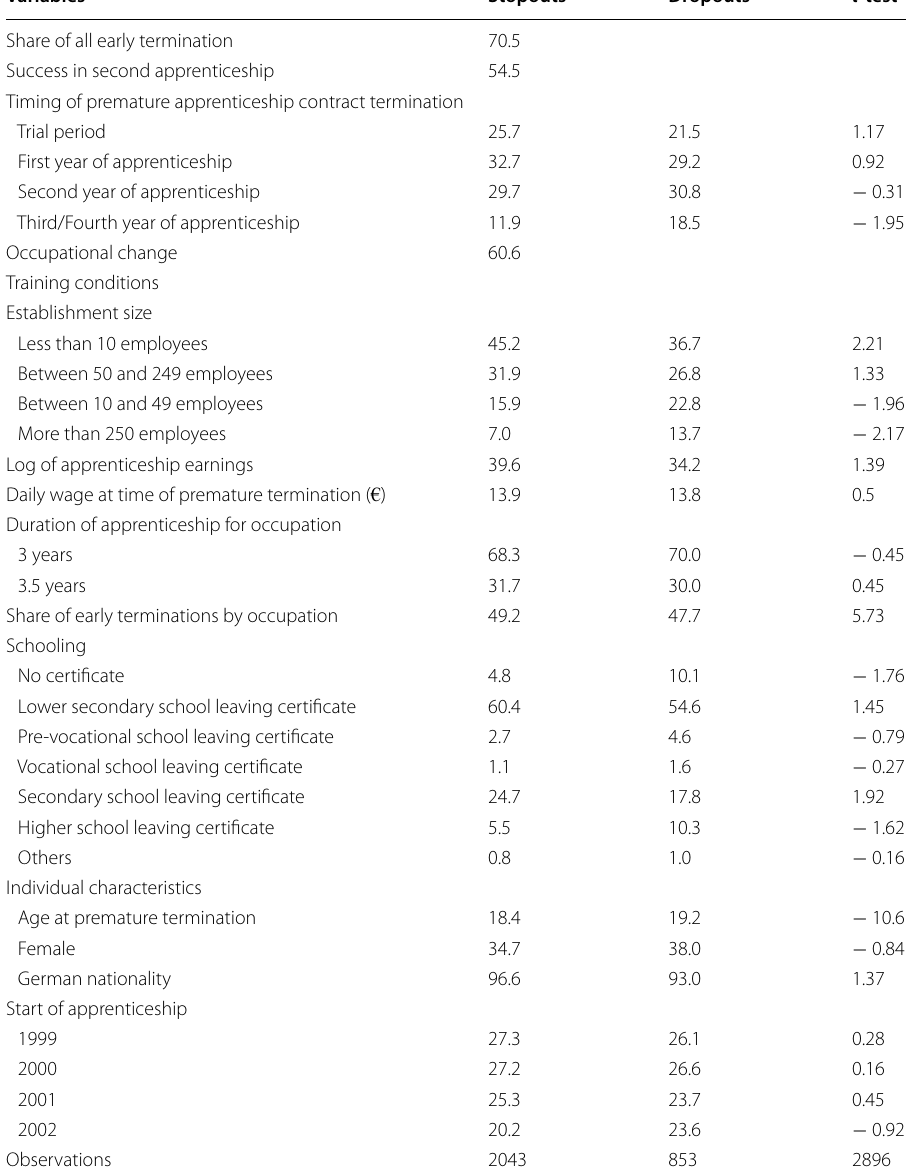
Table 1 Descriptive statistics of stopouts and